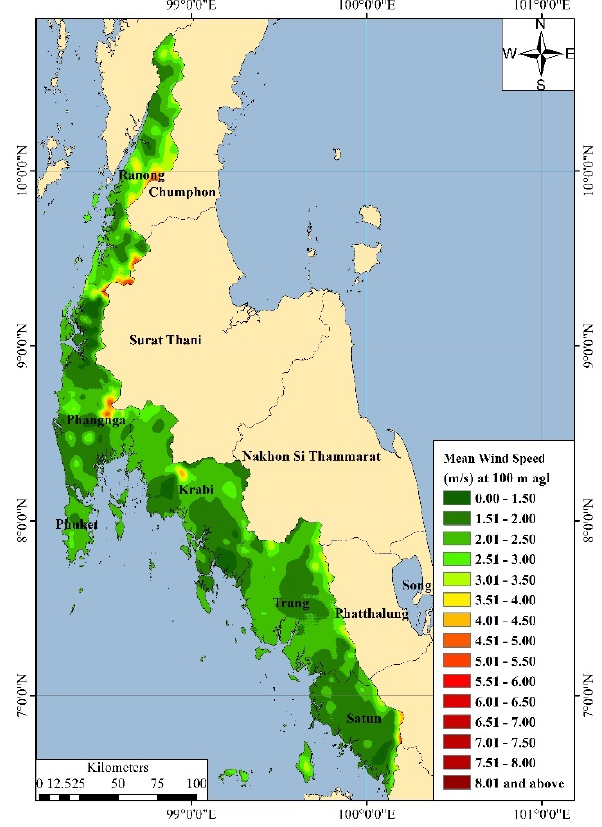
Figure 5. Microscale wind resource map at 100 m agl for the western coast of Southern Thailand.